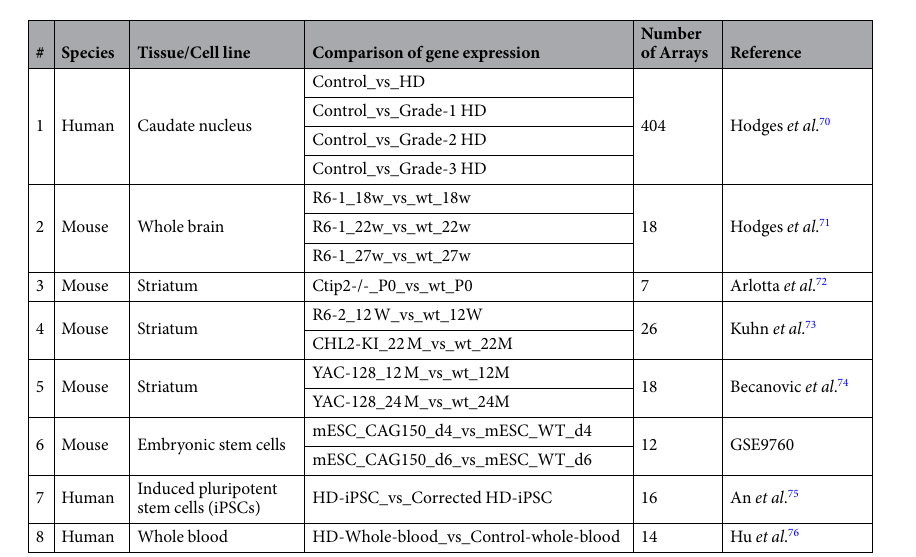
Table 2. Gene expression datasets for human HD samples and mouse models that are integrated in HDNetDB. The comparisons that can be used for selection and filtering of networks are